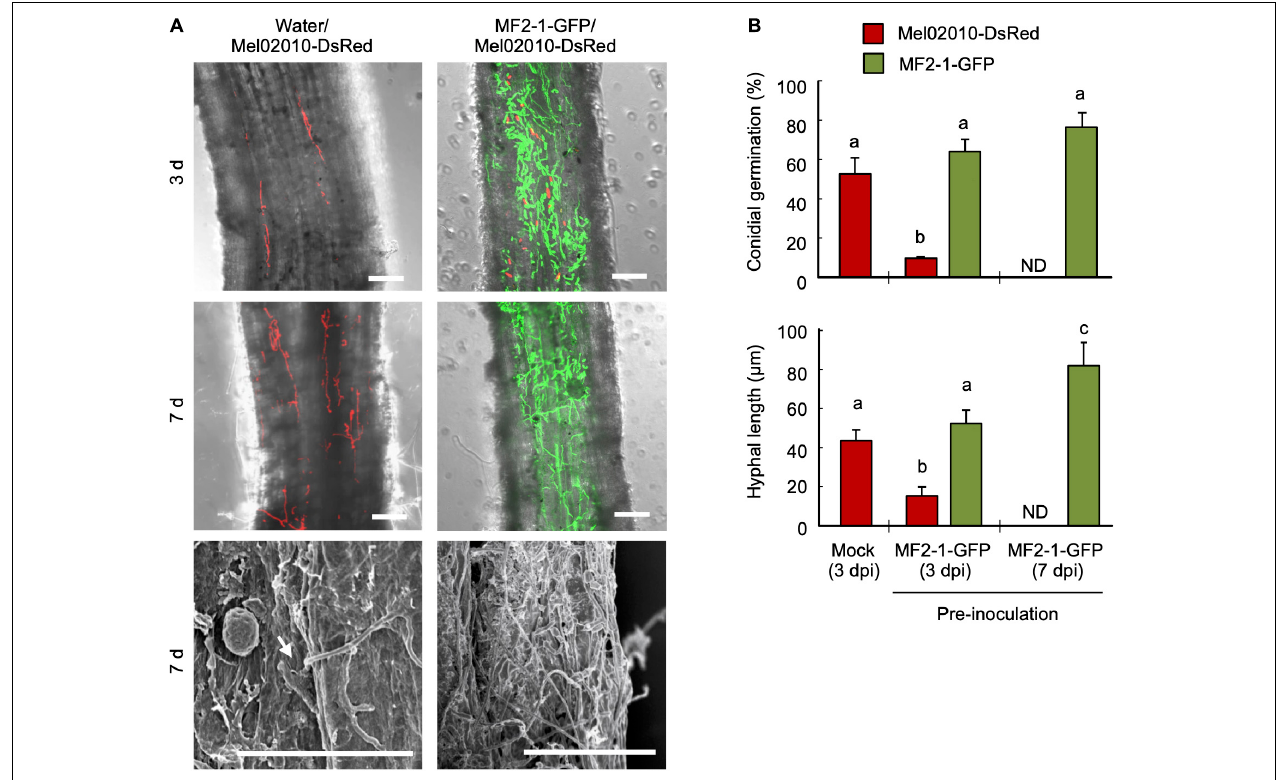
FIGURE 6 | Inhibition of conidial germination and hyphal growth of wild-type strain on root surface after pre-inoculation with (cid:49) FOW2 strain. Roots of melon seedlings were dipped in a conidial suspension (1 × 10 8 conidia/mL) of (cid:49) FOW2 strain MF2-1-GFP or in water, and seedlings were planted in soil infested with wild-type strain Mel02010-DsRed (1 × 10 5 conidia/g soil). Seedlings were removed from soil at 3 and 7 dpi. (A) The root surface was viewed with laser scanning confocal microscopy (LSCM; top and middle) or scanning electron microscopy (bottom). Bar = 50 µ m. Arrow: possible penetration site. (B) Percentage of conidial germination and hyphal length of each strain on main roots at 3 and 7 dpi was determined using LSCM. Data represent means and standard errors of three replications. Columns with different letters indicate that means differed significantly at P ≤ 0.01 in the Tukey–Kramer multiple range test. ND, not